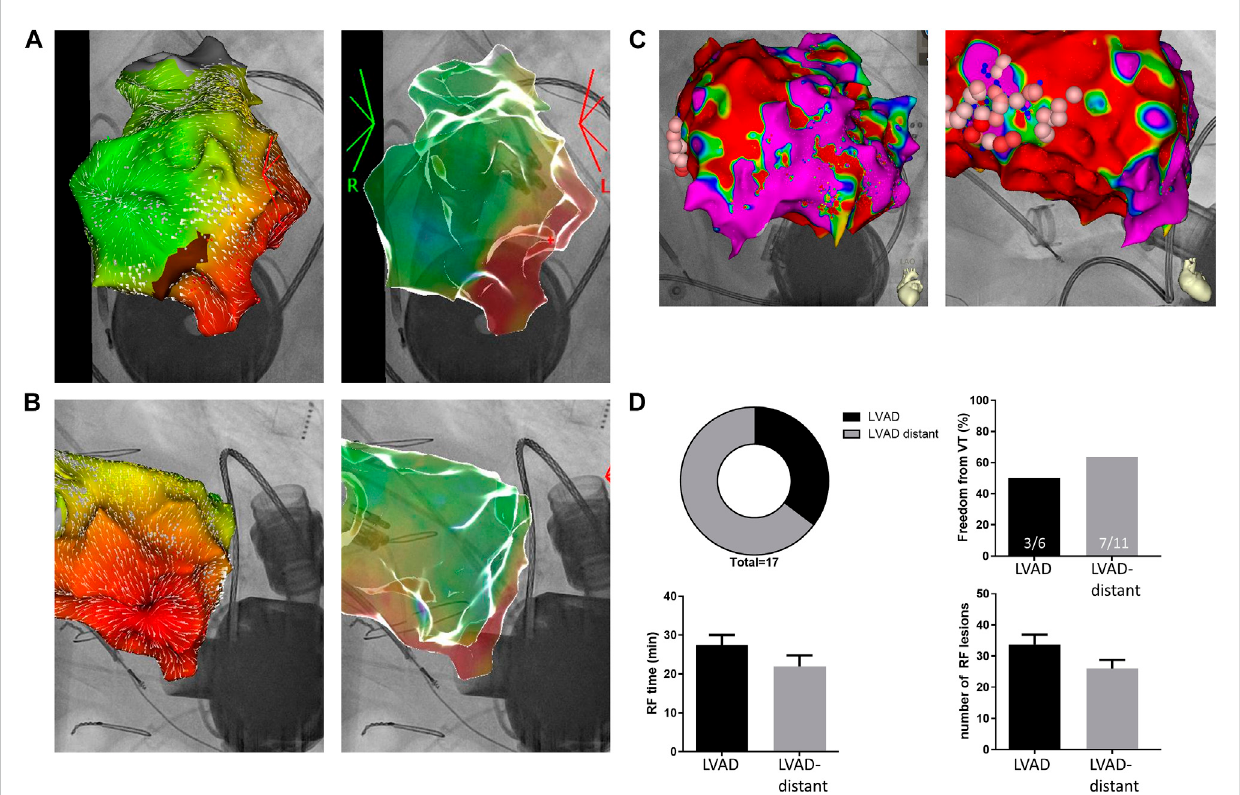
FIGURE 1 (A and B) . LVAD related VT: Anterior-posterior AP; (A) and left anterior oblique LAO; (B) view of the left ventricle. CARTOUNIVU overlay of 3D electroanatomicmap[localactivationtimeandcarto-con fi dence(whitearrows)map]andX-rayimage.Mappingwasperformedduringanongoingfocal VT from the LVAD insertion site. (C) . Non-LVAD related VT patient: AP (left) and LAO (right) view of the left ventricle. CARTOUNIVU overlay of 3D electroanatomic map (bipolar voltage map; red areas < 1.5 mV) with marked ablation sites distant from the LVAD cannula. (D) . Distribution of LVAD associated and non-LVAD associated VT in LVAD patients and freedom from VT (top). Time of radiofrequency ablation (RF time) as well as number of radiofrequency ablation lesions (bottom). Patients had either an LVAD with LVAD-related or non-LVAD related VTs